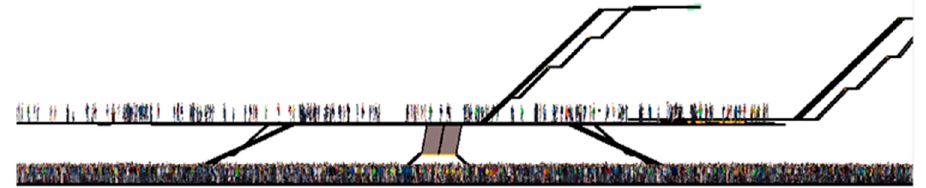
Figure 15. Distribution of evacuation people.